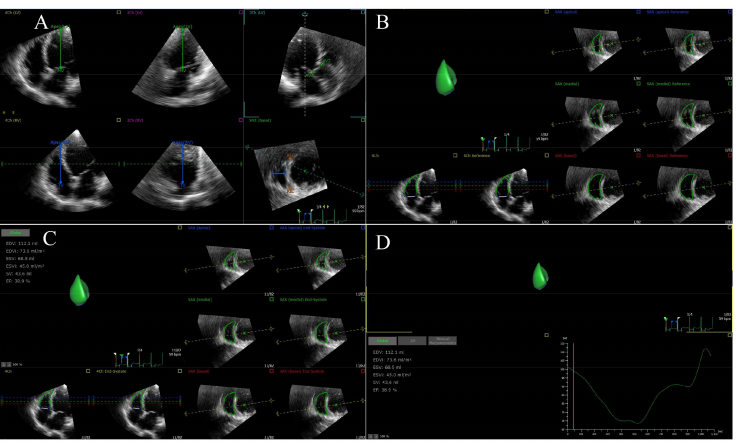
Figure 3. RVEF using 3 DE in a patient with HFrEF. ( A ) Setting reference points; ( B ) RV endocardial border identification and tracking at end-diastole; ( C ) RV endocardial border identification and tracking at end-systole; ( D ) RVEF is automatically generated. RVEF, right ventricular ejection fraction; 3 DE, three-dimensional